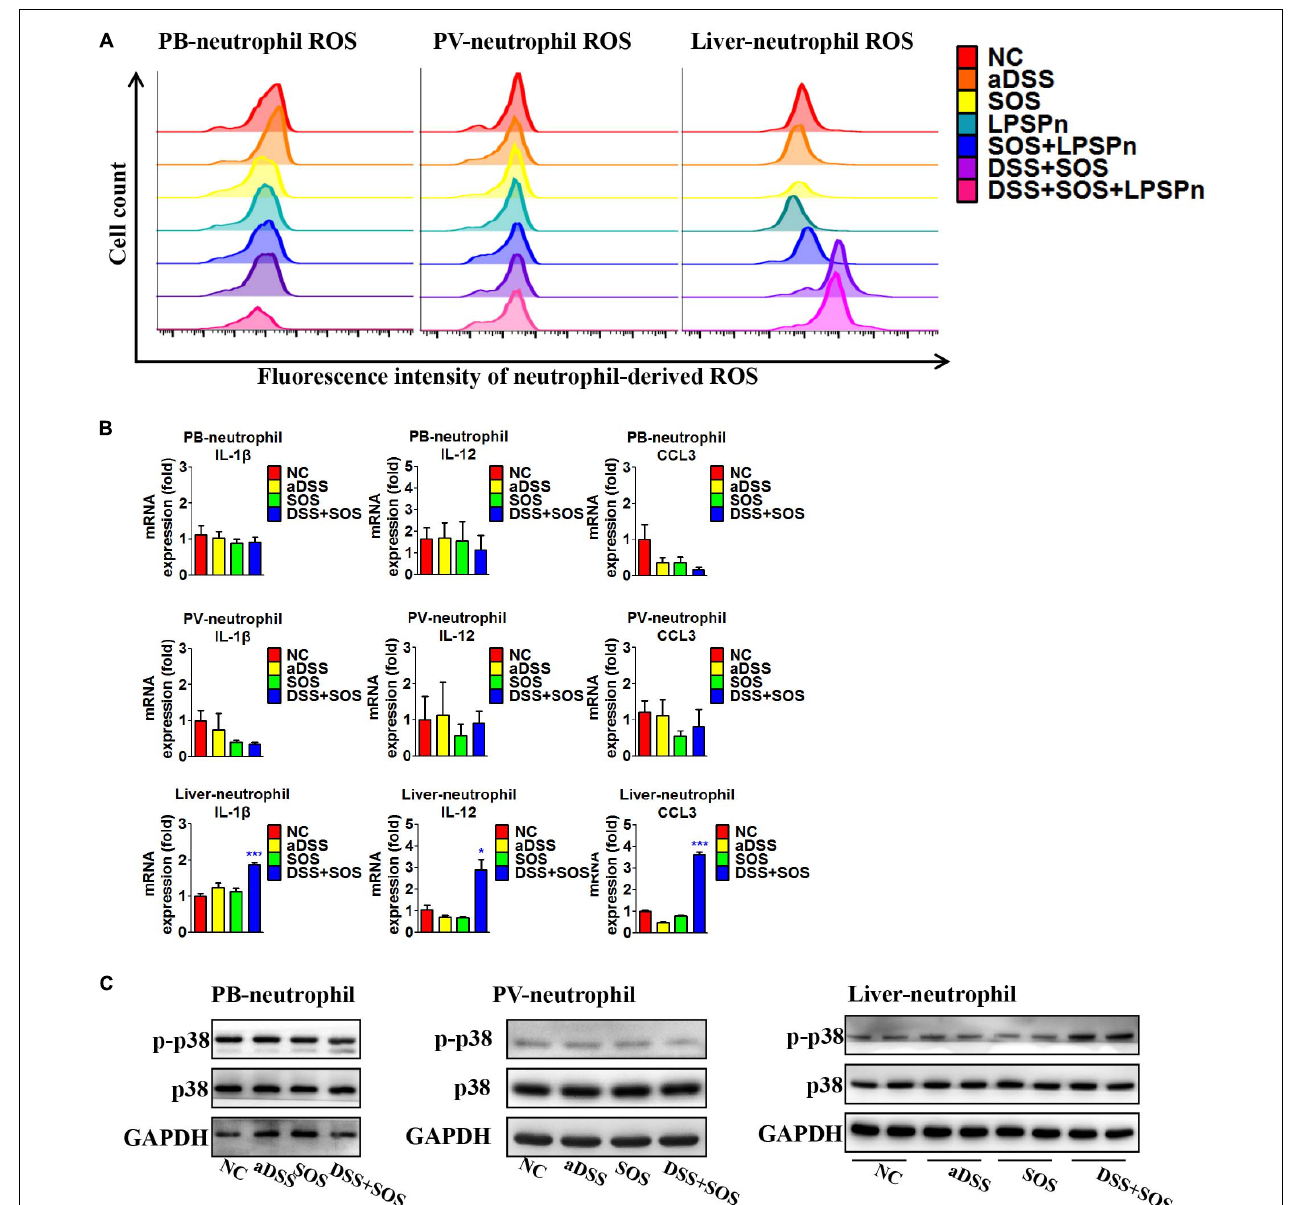
FIGURE 5 | In colitis-induced liver injury, neutrophils are activated in the liver. The activation status of neutrophils was evaluated via neutrophil-derived reactive oxygen species (ROS), neutrophil-derived cytokines, and phosphorylation of p38. (A) Neutrophil-derived ROS in the peripheral blood (PB), portal vein (PV), and liver were tested via flow cytometry in the following seven groups: normal control (NC), acute dextran sulfate sodium colitis (aDSS), sinusoidal obstruction syndrome (SOS), lipopolysaccharide-induced pneumonia (LPSPn), SOS + LPSPn, DSS + SOS, and DSS + SOS + LPSPn. (B) Neutrophil-derived cytokines in the peripheral blood, portal vein, and the liver were evaluated in NC, aDSS, SOS, and DSS + SOS groups. (C) The phosphorylation of neutrophil p38 was also tested in the peripheral blood, portal vein, and liver. Asterisk indicates that the level is significantly different with normal control. * p < 0.05; *** p < 0.001 by t -test; n = 5–6 per group; panels A and B are representative of three experiments; panel C is representative of two